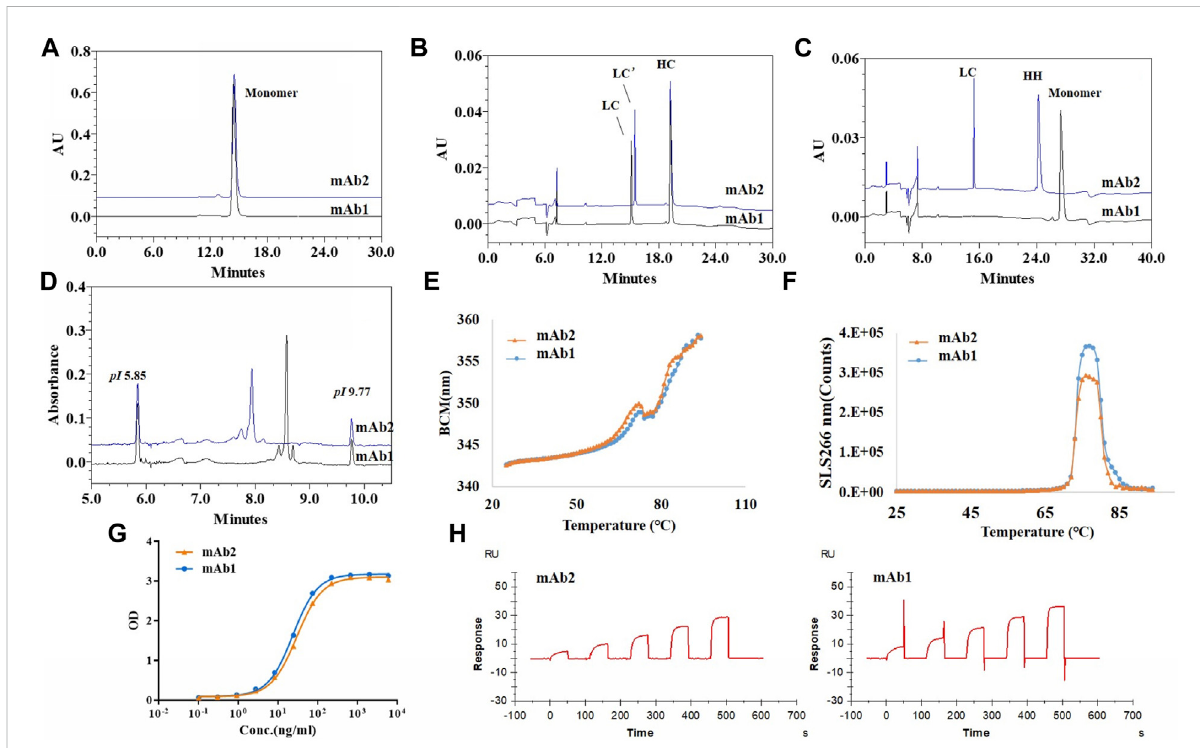
FIGURE 7 StructuralandfunctionalcharacteristicsofantibodywithLCC-termialextension(mAb2)andcontrolantibodywithnormalLC(mAb1). (A) :SEC- HPLC pro fi les of mAb1 and mAb2; (B) : rCE-SDS pro fi les of mAb1 and mAb2; (C) : nrCE-SDS pro fi les of mAb1 and mAb2; (D) : pI and charge pro fi els of mAb1 and mAb2 by iCIEF; (E) : Tm analysis of mAb1 and mAb2 by UNcle intrinsic fl uorescence scanning; (F) : Tagg analysis of mAb1 and mAb2 by UNcle static lightscattering; (G) :Antigen bindingcurvesofmAb1and mAb2byELISA; (H) :FcRn bindingactivities bySPR. NoLC/HCinter-chain disul fi de was formed for mAb2, which brought some purities differences but similar functional properties when compared to mAb1. mAb1, control antibody with normal LC; mAb2, Antibody with LC C-terminal extension; LC ’ : C-terminal extended